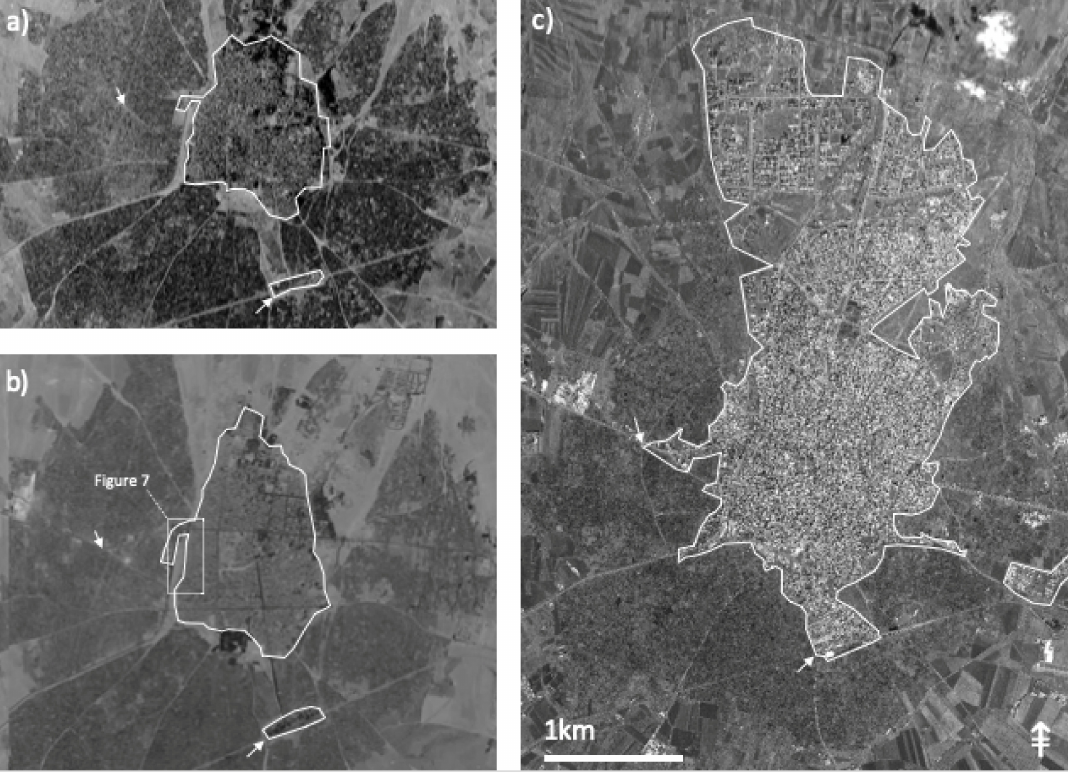
Figure 6. Qazvin, Iran. Urban area in ( a ) 1955, ( b ) 1973 and ( c ) 2005. (Data: Table